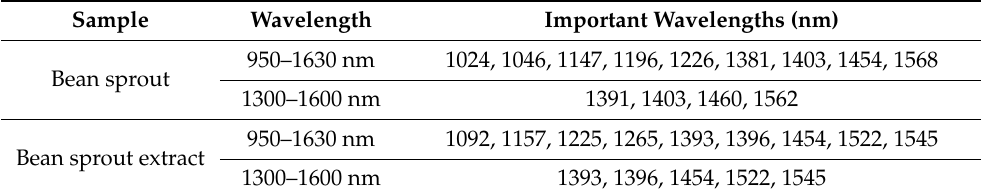
Table 2. Important wavelengths from the NIR spectroscopy measurement for bean sprout and bean sprout extract.